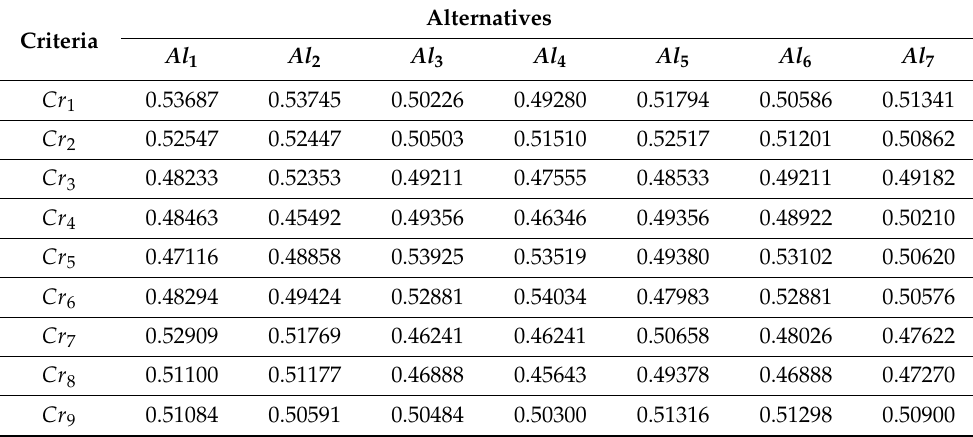
Table 12. Score matrix (cid:123) ij